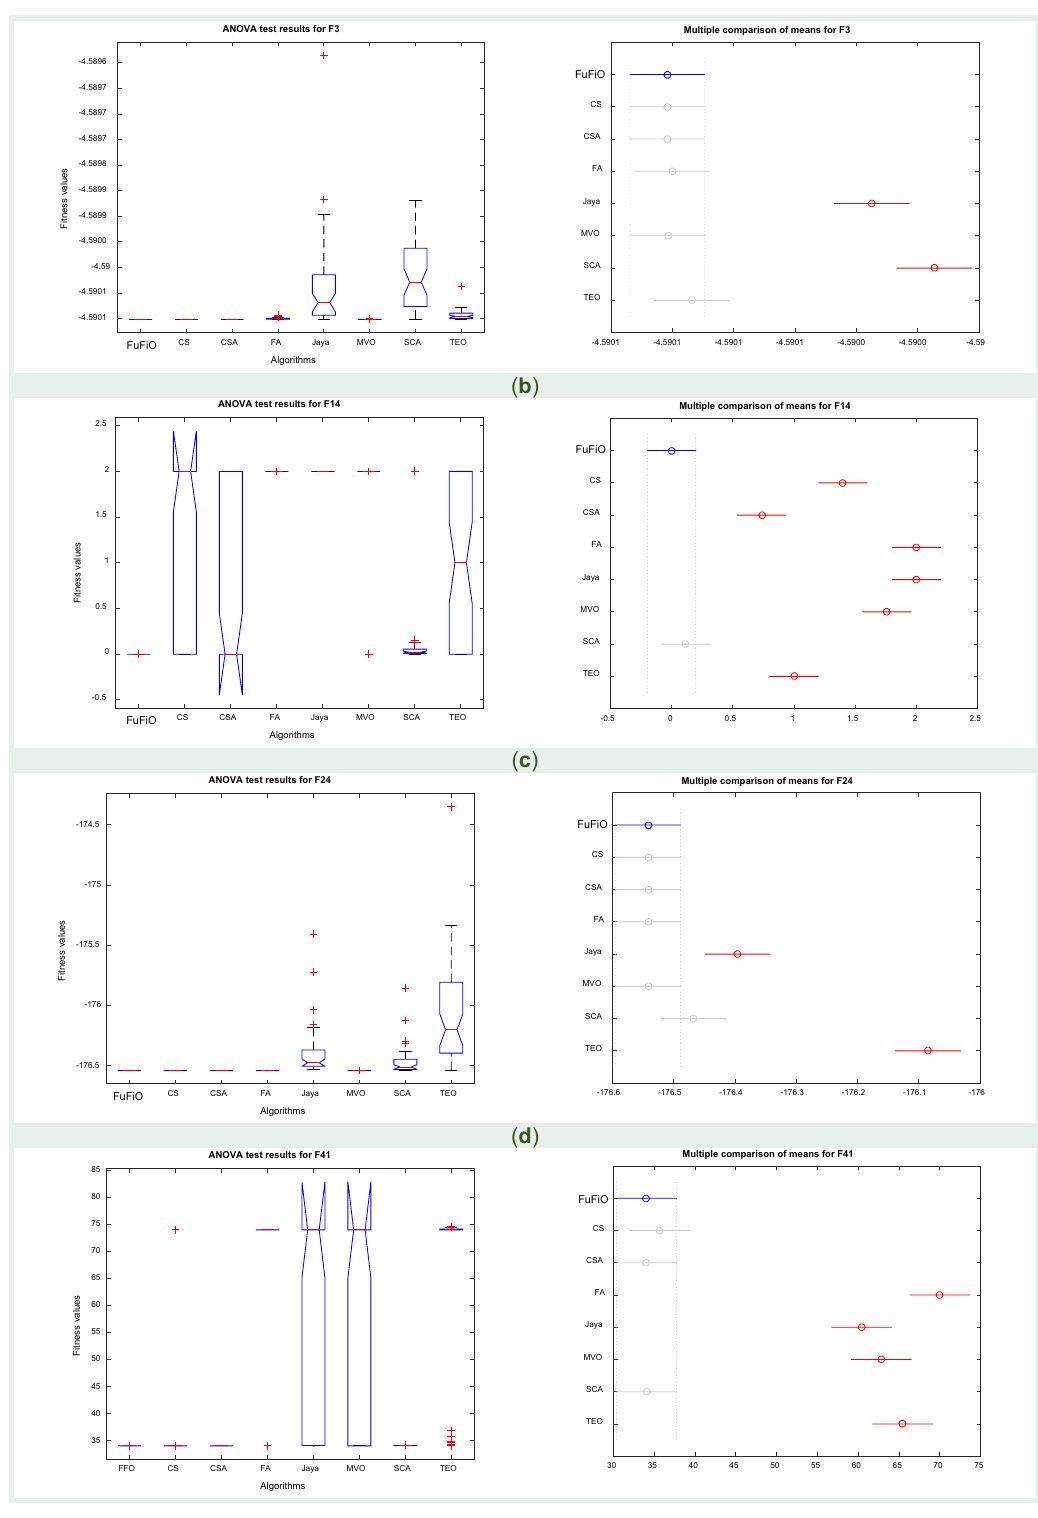
Figure 13. ANOVA test results for fixed-dimension